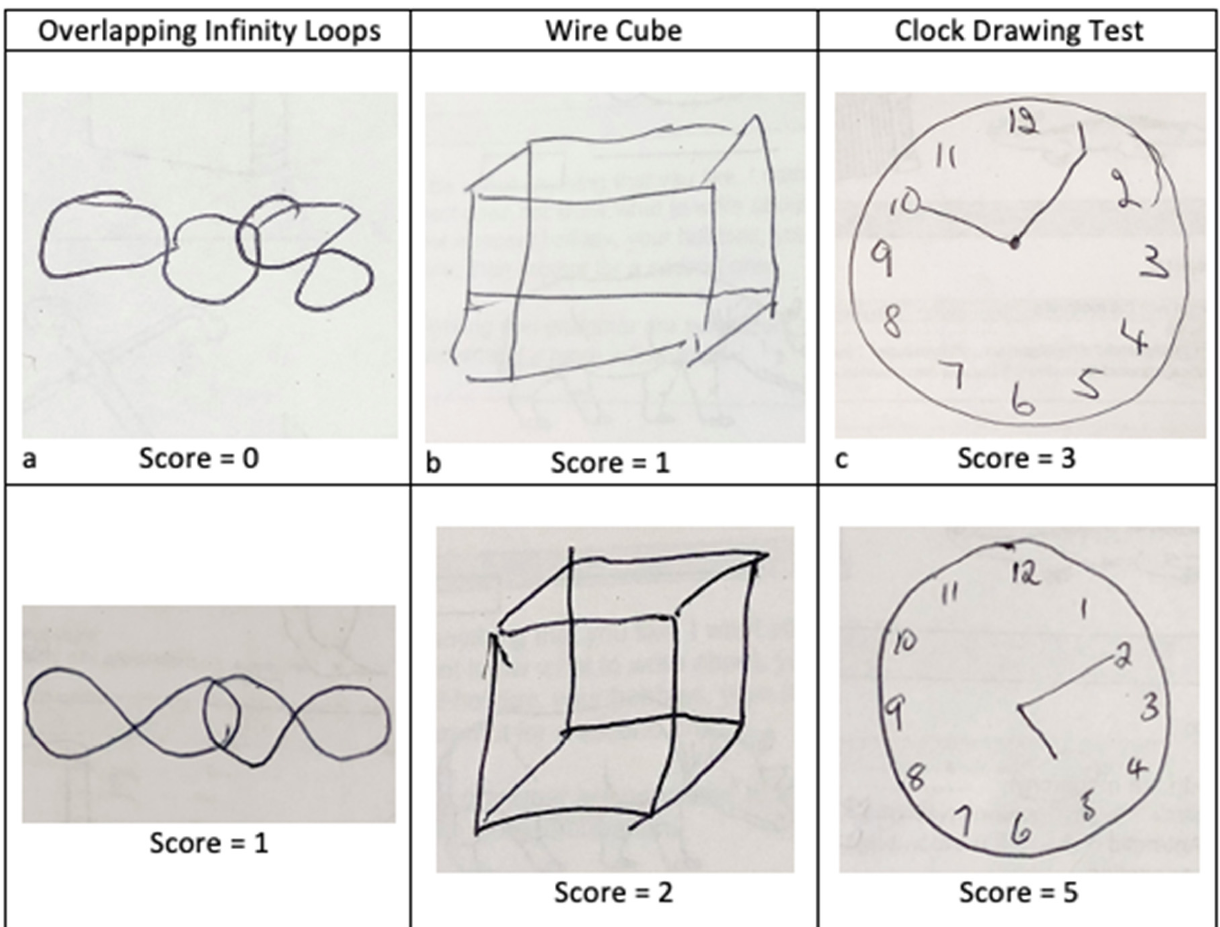
Figure 1. Example drawings of the overlapping infinity loops, wire cube and clock drawing task. ( a ) shows an incorrect drawing with one point lost for incorrect orientation; ( b ) shows a general cube shape is maintained but one point lost for fewer than 12 lines. ( c ) shows a correct clock face (circle and distribution of numbers), but two points are lost for incorrect placement of both hands.